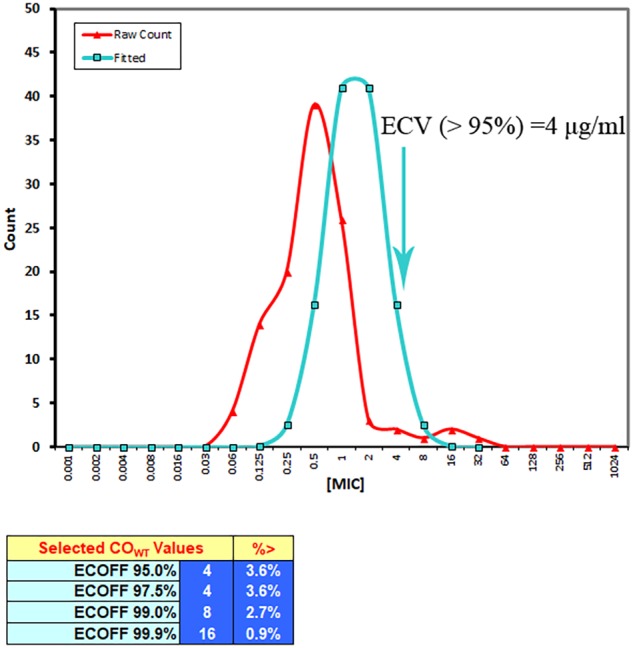
The ECV evaluation using the statistical program “ECOFFinder.”